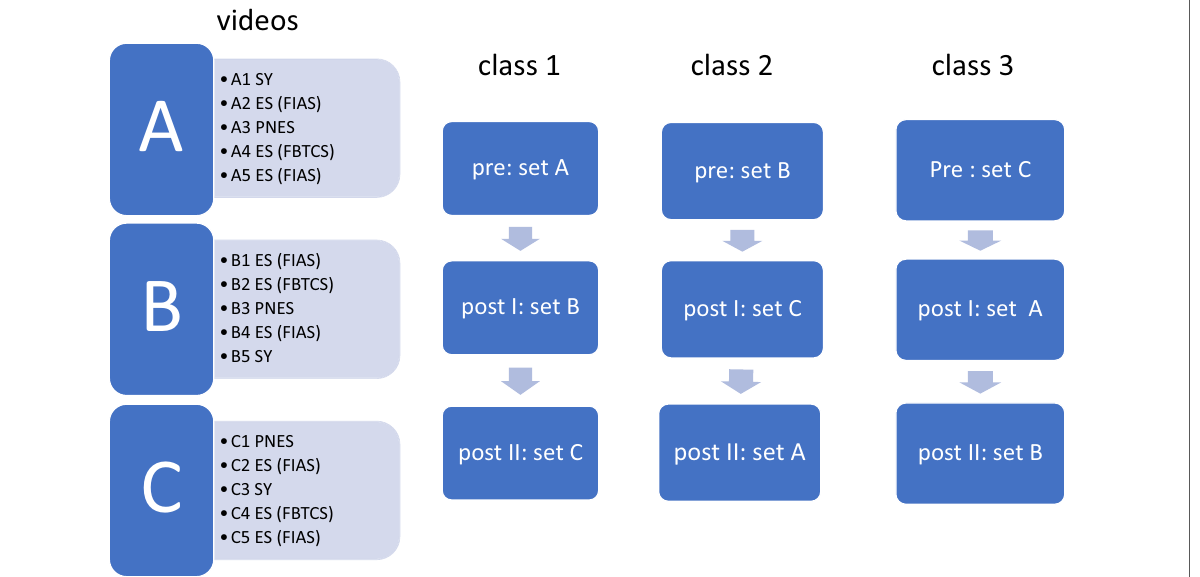
Fig. 1 Sets of videos (A1-5, B1-5, C1-5) including the order of seizure-like event types and the time points (pre, post I and post II lesson) they were